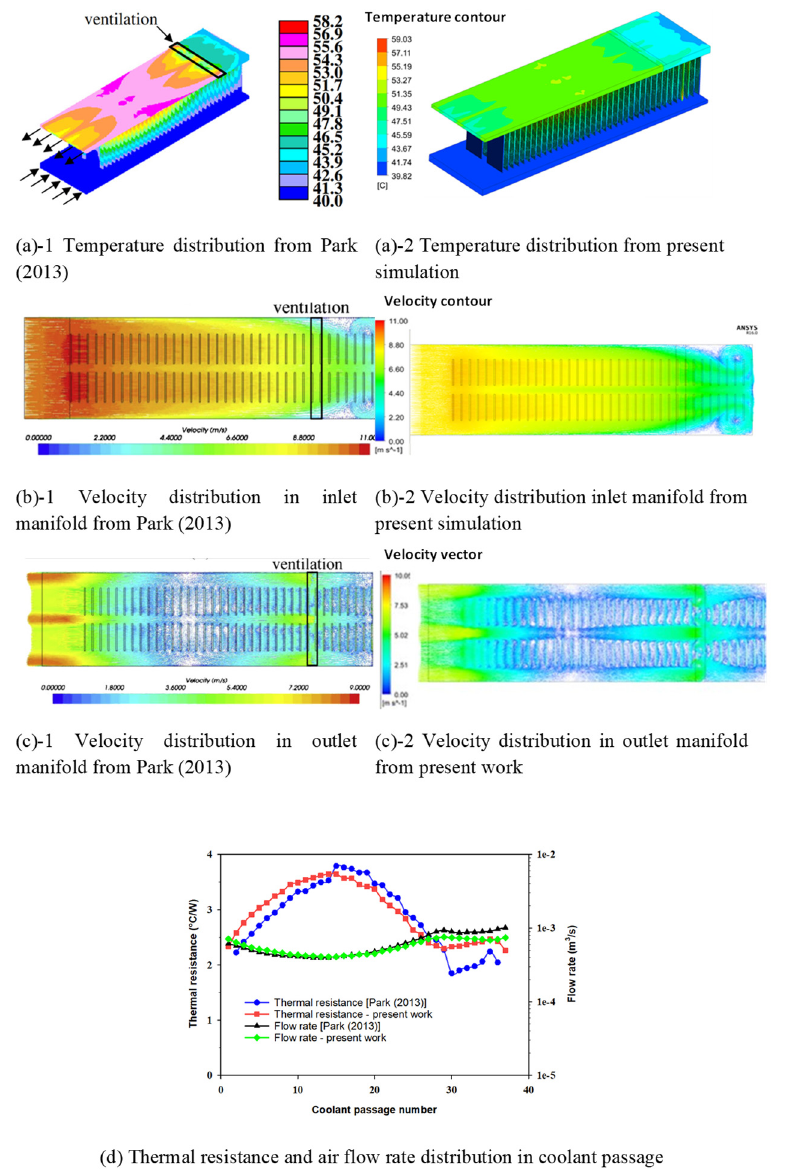
Figure 3. Validation of Park [20]’s configuration with present work.